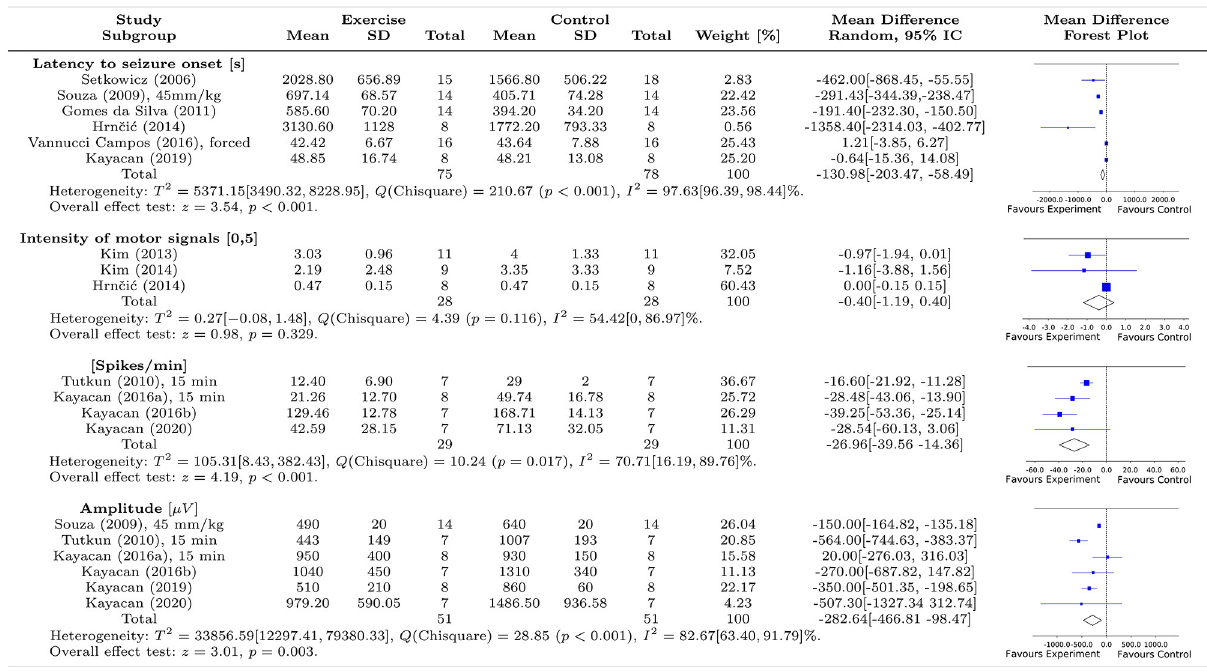
FIGURE 4 | Summary of the meta-analysis on the effect of exercise on seizure susceptibility in animal models. The first column shows the studies included in this analysis, while the subsequent columns display the statistical features, mean and standard deviation (STD), related to experimental and control groups, respectively. The seventh column shows the weights associated with each study, calculated from the variance and number of animals. The eighth column shows the mean effect differences and their respective confidence intervals (CI 95%), assuming a random-effects approach, with between- and within-study heterogeneity given by T 2 and I 2 . The last column displays the Forest plots associated with each analysis of each epileptogenic characteristic. We evaluated four features associated with the epileptogenic condition; two behavioral features: latency to seizure onset (6 studies) and intensity of motor signals (3 studies); and two electrophysiological features: spike/min (4 studies) and amplitude of spikes (6 studies). Of the behavioral characteristics, only latency to seizure onset showed an overall significant effect ( z = 3.54, p < 0.001) while the two electrophysiological characteristics showed overall statistical significance in favor of exercise to mitigate seizure susceptibility, (spike/min: z = 4.19, p < 0.001, and amplitude of spikes: z = 3.01, p =